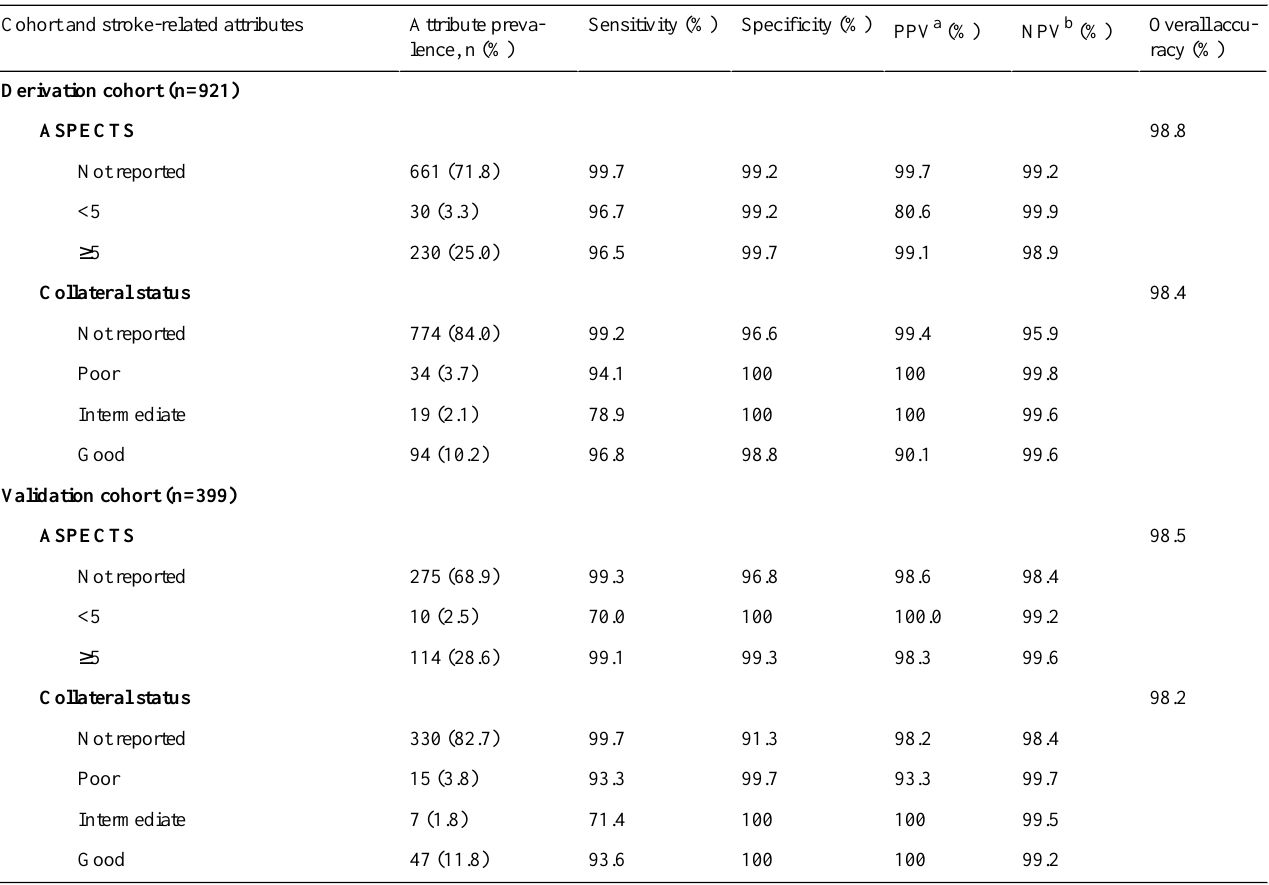
Table 2. Accuracy of the natural language processing tool CHARTextract to identify Alberta stroke program early CT score (ASPECTS) and collateral vascular status based on diagnostic imaging